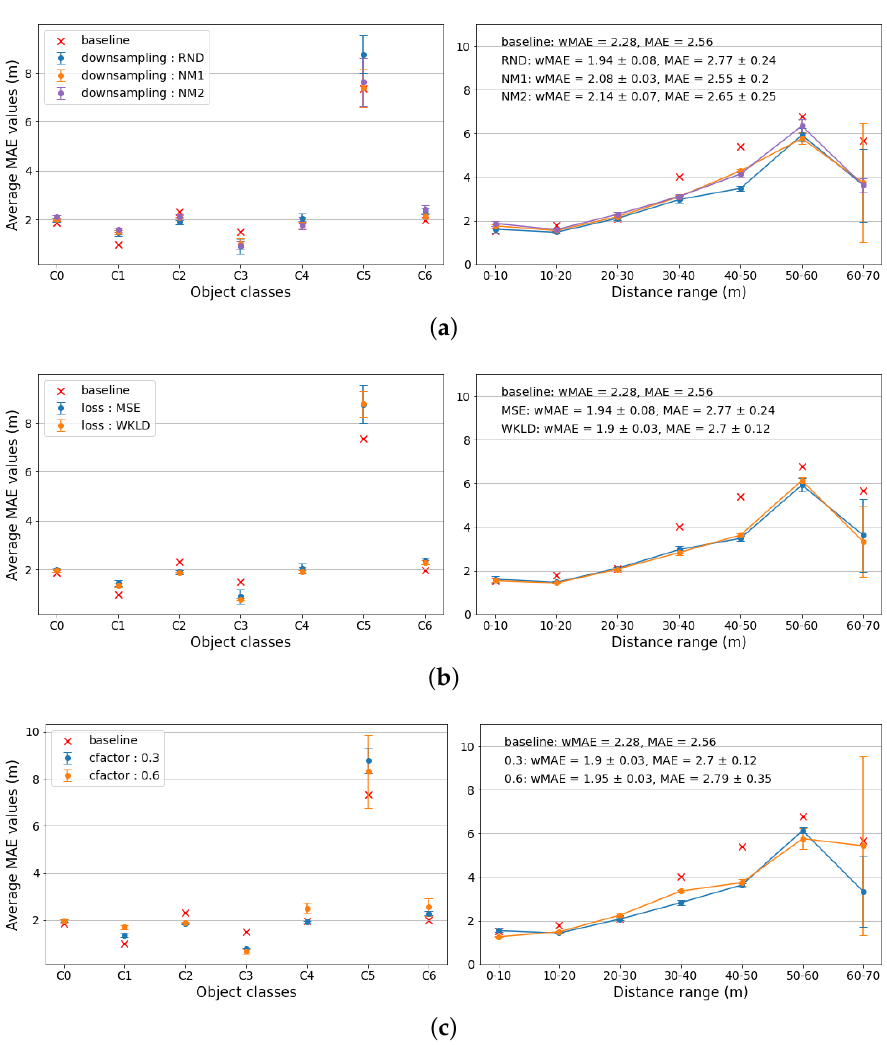
Figure 3. Experimental results for different CDR model settings. The left-hand plots show the MAE values between the model’s predictions and the ground-truth distance values, while the right–hand plots display the MAE metric values distance–wise. Each plot features the baseline (Monodepth2 model) MAE values. Weighted and unweighted average MAE values are shown in the top left corners of the distance plots. Here ( a ) displays the impact of different downsampling strategies on the model’s performance, ( b )—the impact of the loss function choice, ( c )—the impact of the λ c